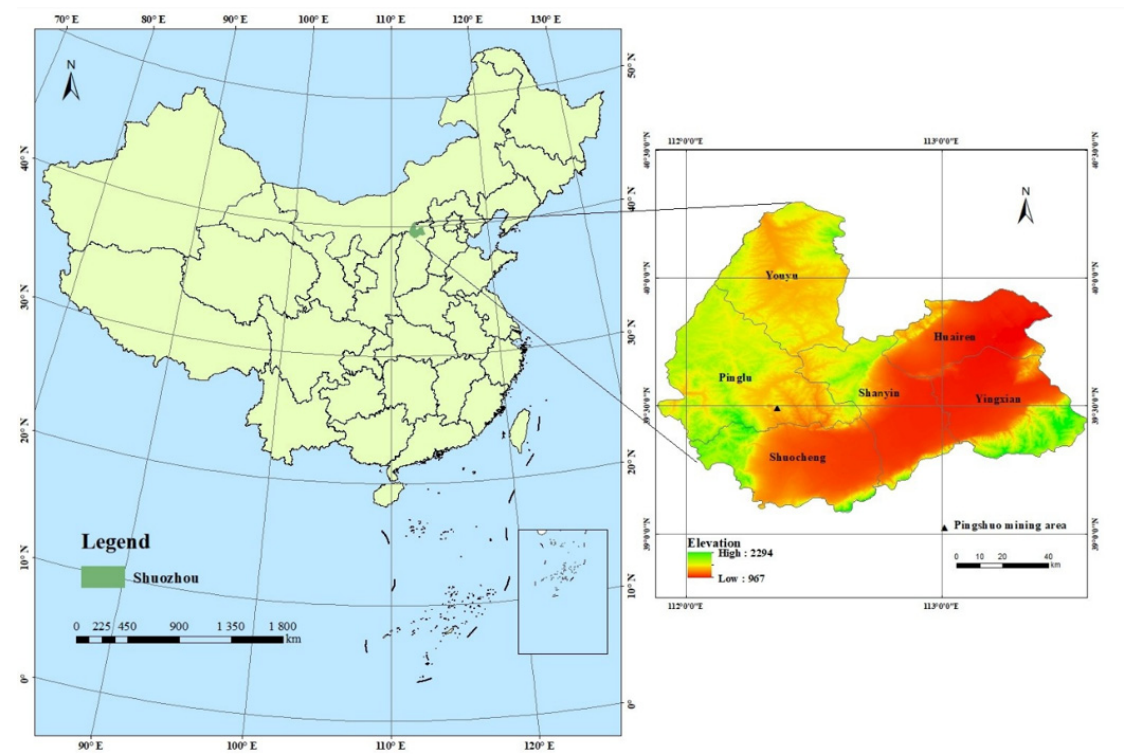
Figure 1. The spatial location of the study